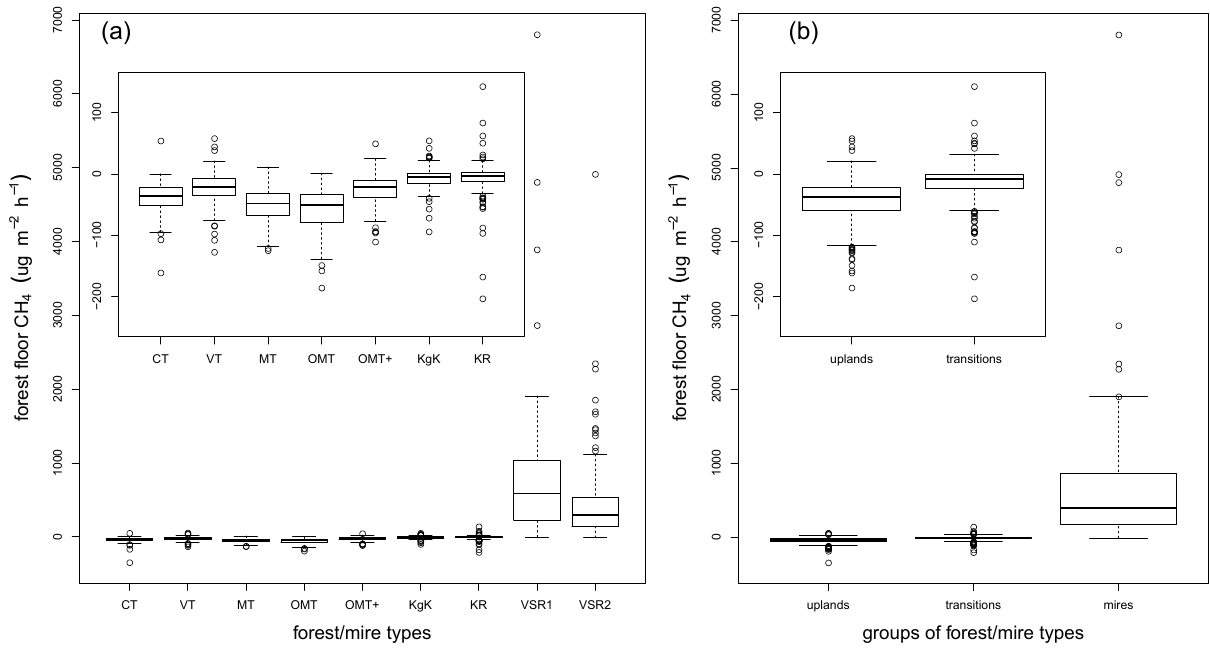
Figure 3. The box plots of forest floor CH 4 fluxes (µgm − 2 h − 1 ) for each forest/mire type (a), and (b) for uplands (CT, VT, MT, OMT), transitions (OMT + , KgK, KR), and mires (VSR1, VSR2) during the whole period. The left–right arrangement of sites mimics the locations on the slope (see Fig.